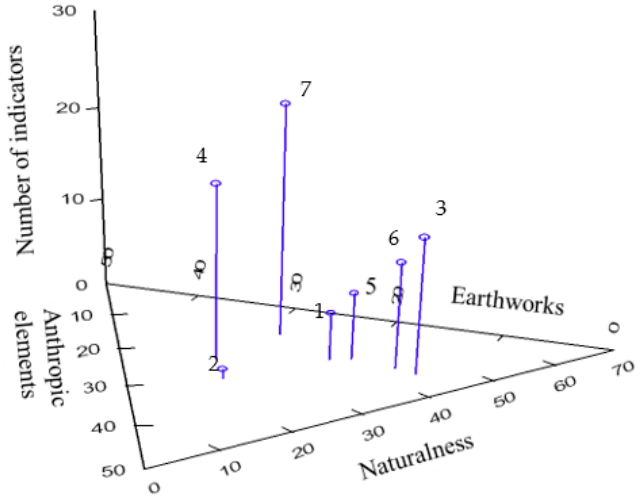
Figure 8. Four-variable diagram of the three impact types and the number of indicator insect species of the seven habitats. The triangle configuration has each side numbered as percentage. Spikes from each habitat point are drawn to facilitate inspection.